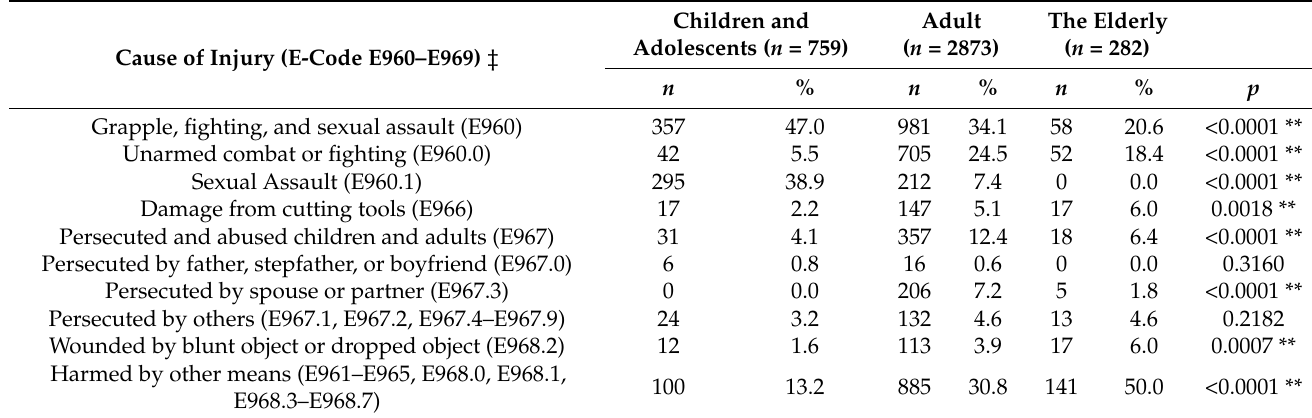
Table 2. Causes of Injury of Victims of Violence in Different Generations (Women).